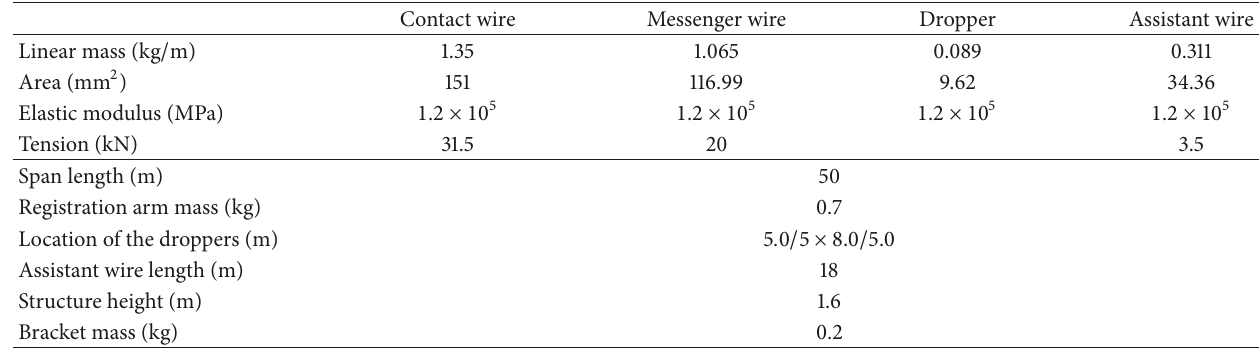
Table 7: Parameters of the elastic stitched catenary.